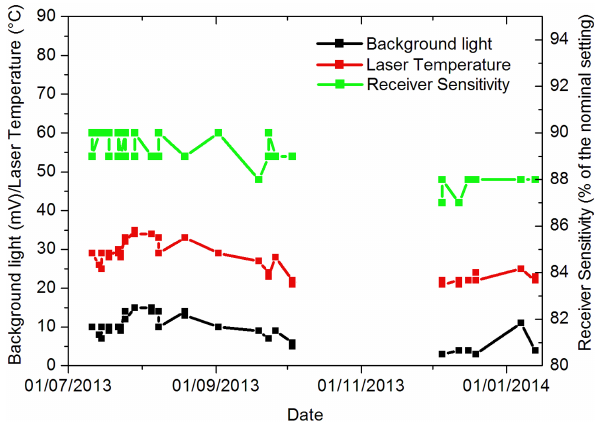
Figure 3. background light (dark squares), laser temperature (red squares), and receiver sensitivity (green squares) as measured by the internal sensors of the CT25K ceilometer are reported for the cases selected for the comparison with MUSA. The period where no data are plotted corresponds to the an EARLINET intercompar- ison campaign in which MUSA was involved and moved for an in- tercomparison campaign in southern Italy (Wandinger et al.,